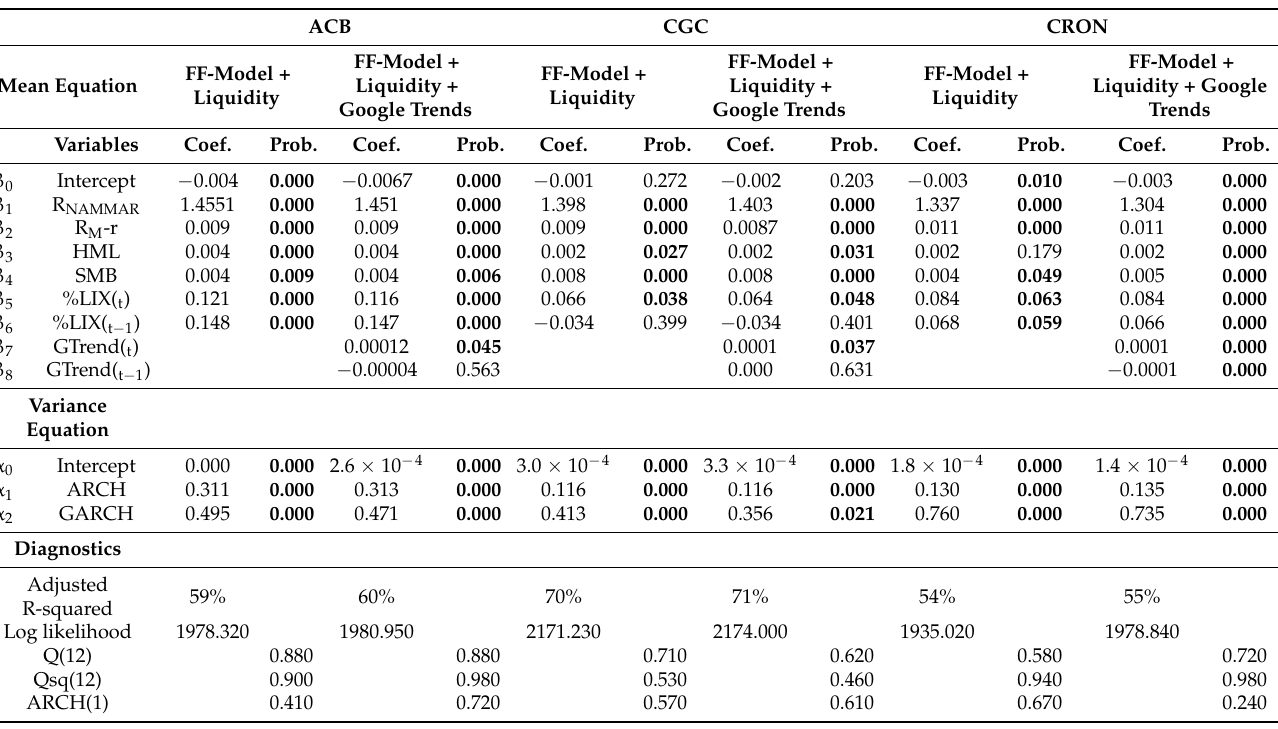
Table 1. Maximum likelihood estimations using symmetric generalized autoregressive conditional heteroscedasticity, GARCH (1,1)